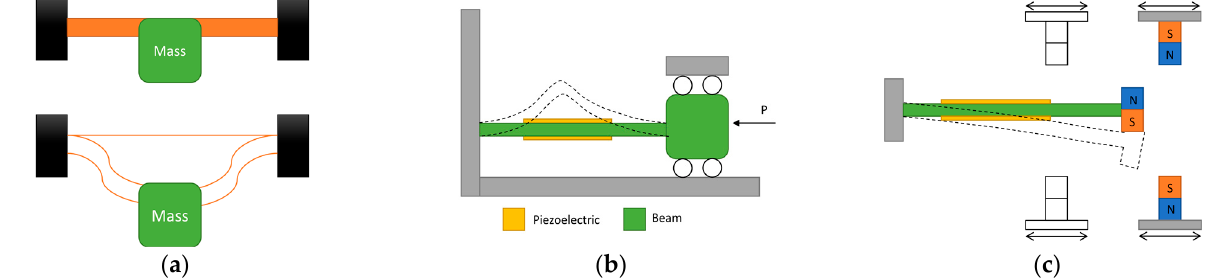
Figure 4. Types of mechanical stress for a rectangular piezoelectric device: ( a ) mechanical stress; ( b ) mechanical charge; ( c ) magnetic force.